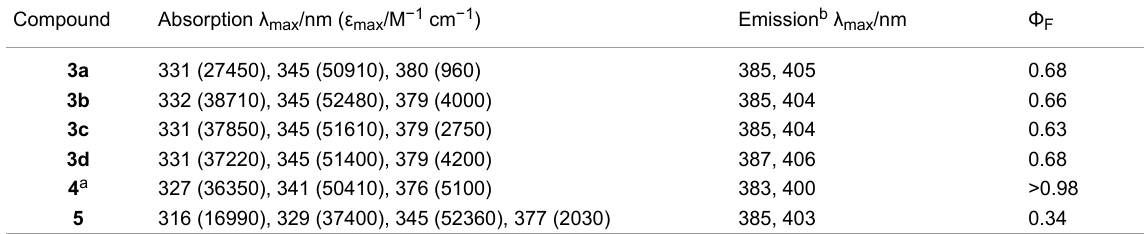
Table 1: Steady-state absorption and emission data for 3a – d , 4 , 5 in CHCl 3 solutions ( c = 10 − 6 M). Compound